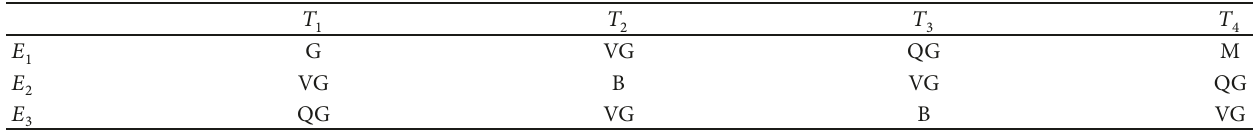
̃𝐿 provided by the expert Ζ 1 .